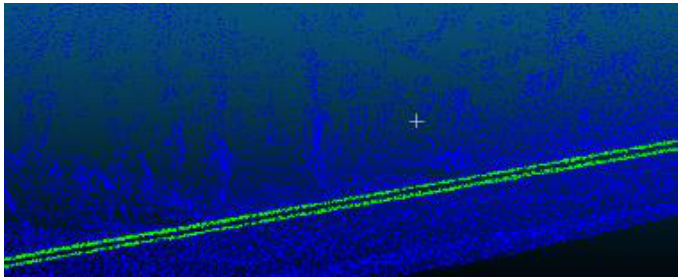
Figure 8. In green, upper and lower curb edges detected in Test Site 1.